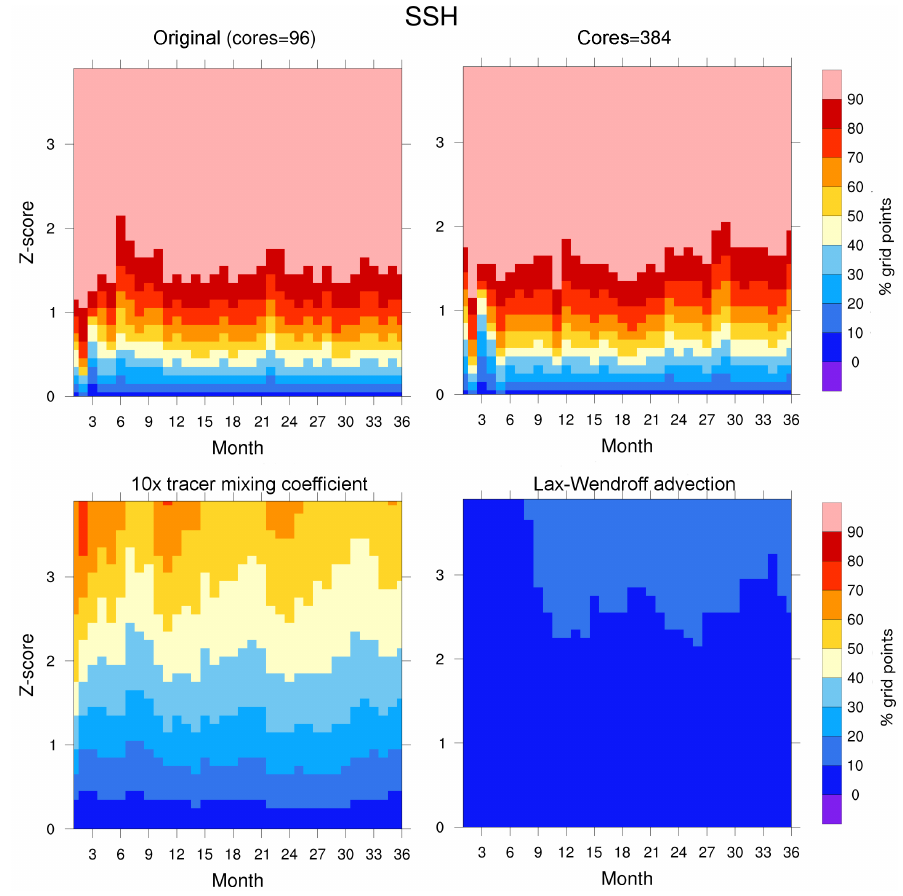
Figure 9. Response surfaces for Z -score of sea surface height (SSH) over time (monthly) and Z -score threshold. The top two panels represent two different processor core layouts. The bottom left has a tracer mixing coefficient for convective instability 10 times larger than the original (100000.0), and the bottom right uses a different tracer advection scheme (Lax–Wendroff scheme with 1-D flux limiters). The color bar indicates the percentage of grid points with a Z -score below the Z -score tolerance (on the y axis).